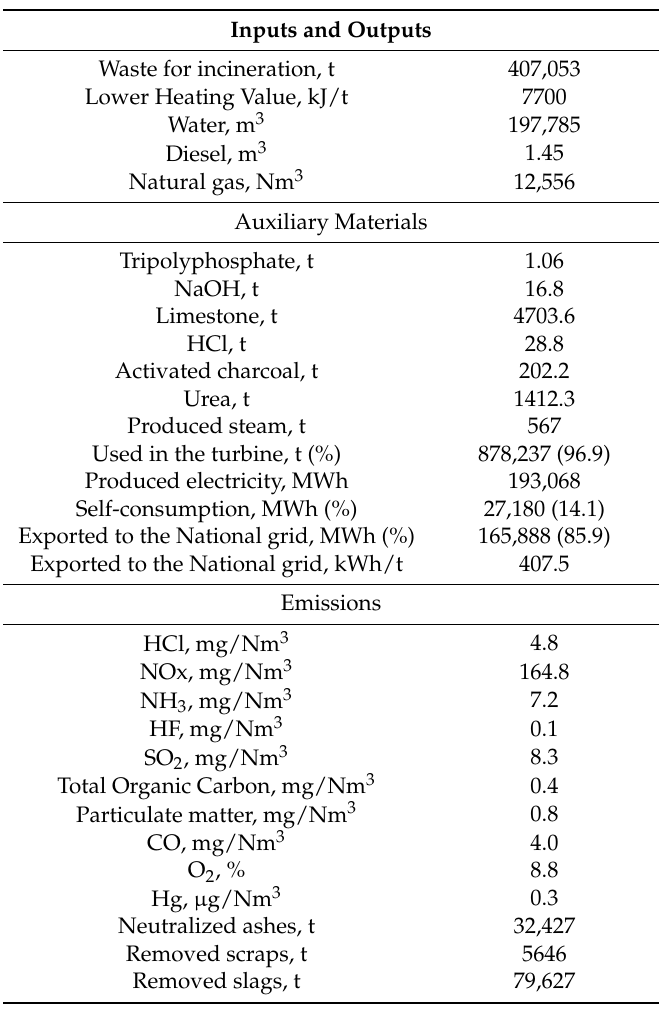
Figure 2. GaBi plan for the reference case (scenario 0)—Portuguese case study. Table 3. Main lifecycle inventory for the studied ERP (annual data referred for 2015).